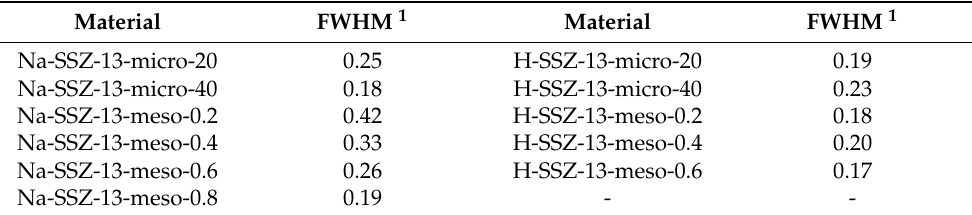
1 Full width half maximum of the main peak.